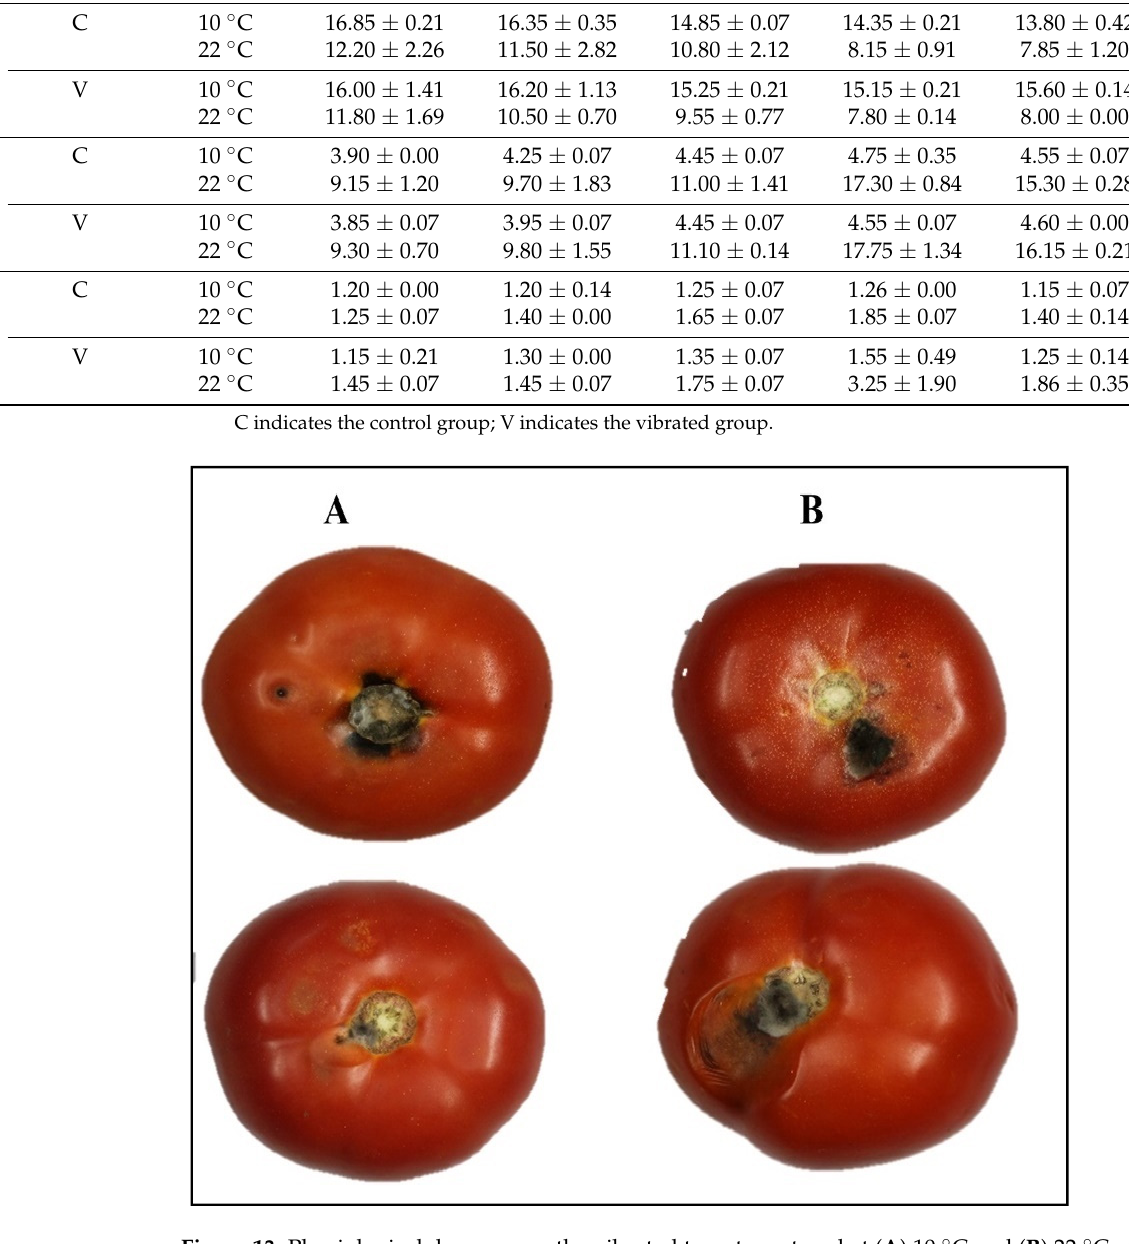
Figure 13. Physiological damages on the vibrated tomatoes stored at ( A ) 10 °C and ( B ) 22 °C after 10 days of storage .